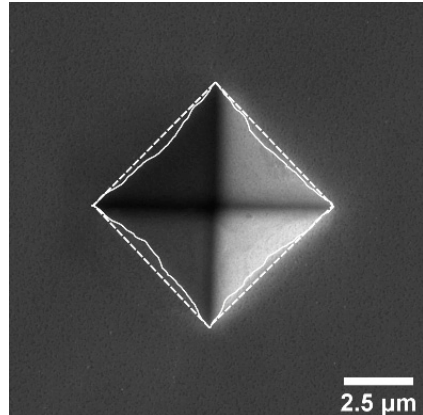
Figure 3. Scanning electron microscope (SEM) image of the indented area ( F max = 10 mN) on the crystallographic (100) orientation of aluminum single crystal (aligned). A p is enclosed by the solid and A c by the dashed line.